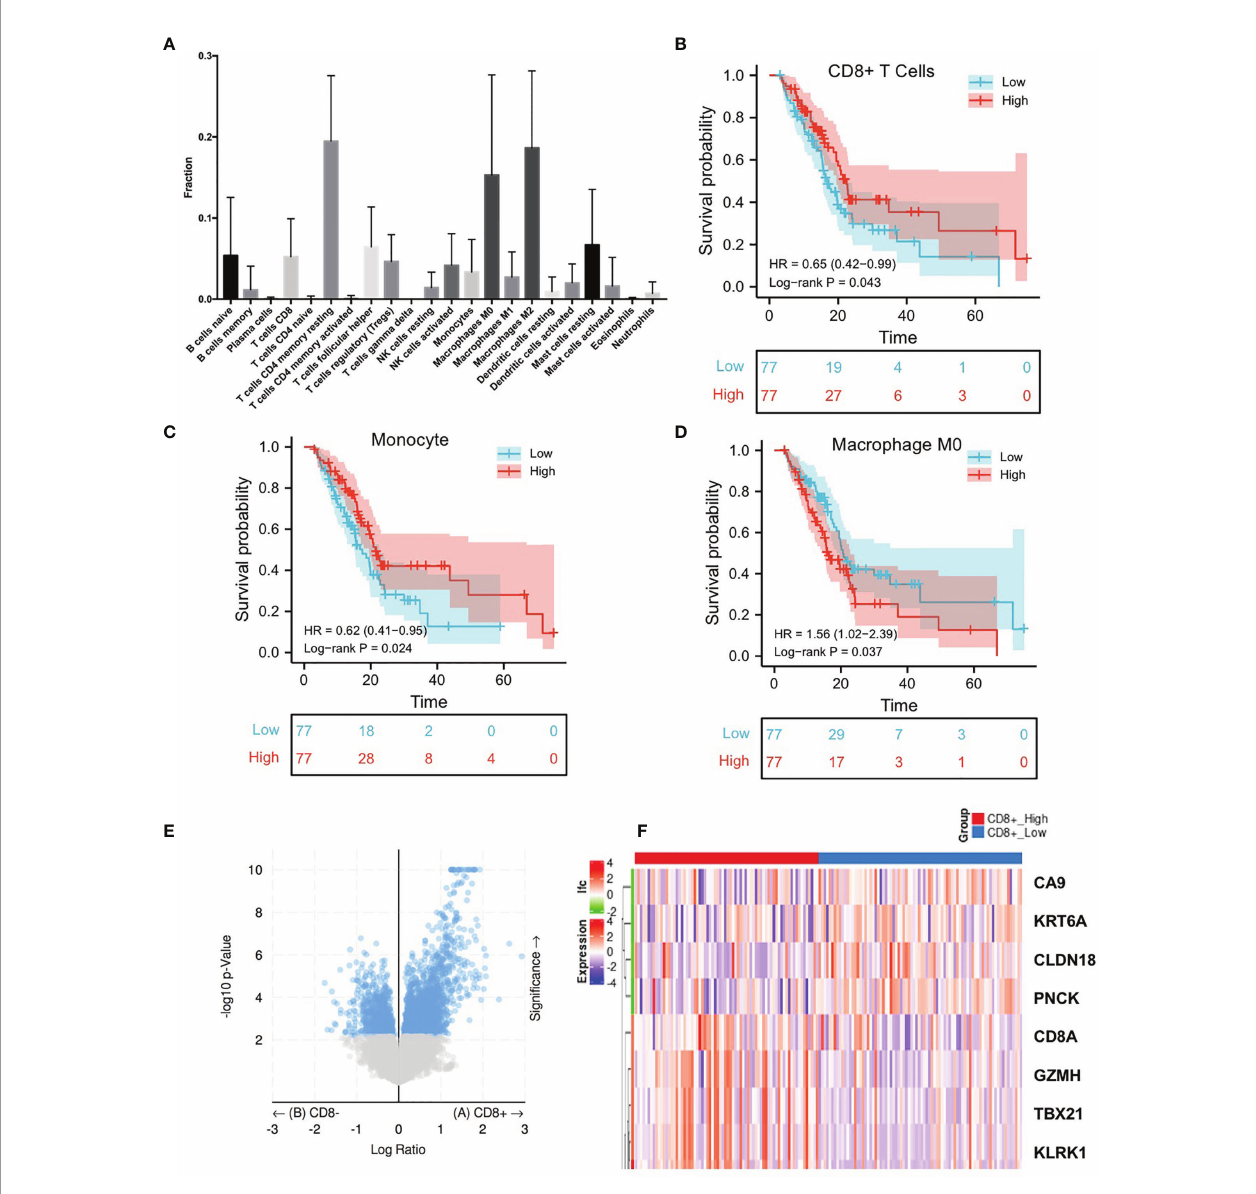
FIGURE 1 | Comprehensive analysis of TME components of TCGA pancreatic cancer patients indicate the prognostic value of CD8+ T cells. (A) TCGA pancreatic cancer transcriptome sequencing data CIBERSORT analysis results show the main in fi ltrating immune cells in pancreatic cancer. (B – D) TCGA data suggest that the prognosis of patients with pancreatic cancer with high CD8+ T cell in fi ltration, high monocyte in fi ltration, and low macrophage M0 is signi fi cantly better. (E) Volcano plots of DEGs between CD8+ T cells high in fi ltration group and low group. X-axis indicates the fold change (log scaled), whereas the Y-axis shows the p values (log scaled). Each symbol represents a different gene, and the red/blue color of the symbols categorize the upregulated/downregulated genes falling under different criteria (p value and fold change threshold). p value <0.05 is considered as statistically signi fi cant, whereas fold change >1 is set as the threshold. (F) Heatmaps of the top 8 DEGs between between CD8+ T cells high in fi ltration group and low